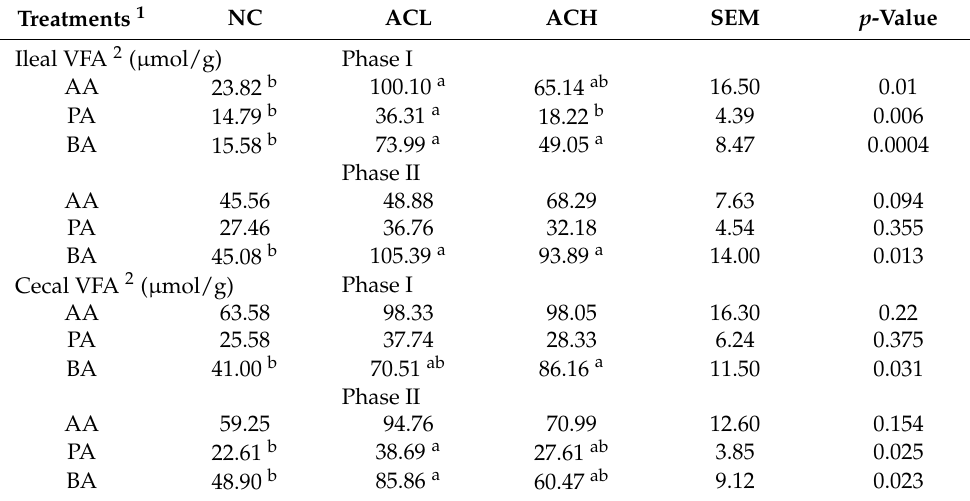
Table 9. Effect of different levels of aging corn on volatile fatty acids in ileal and cecal chyme of